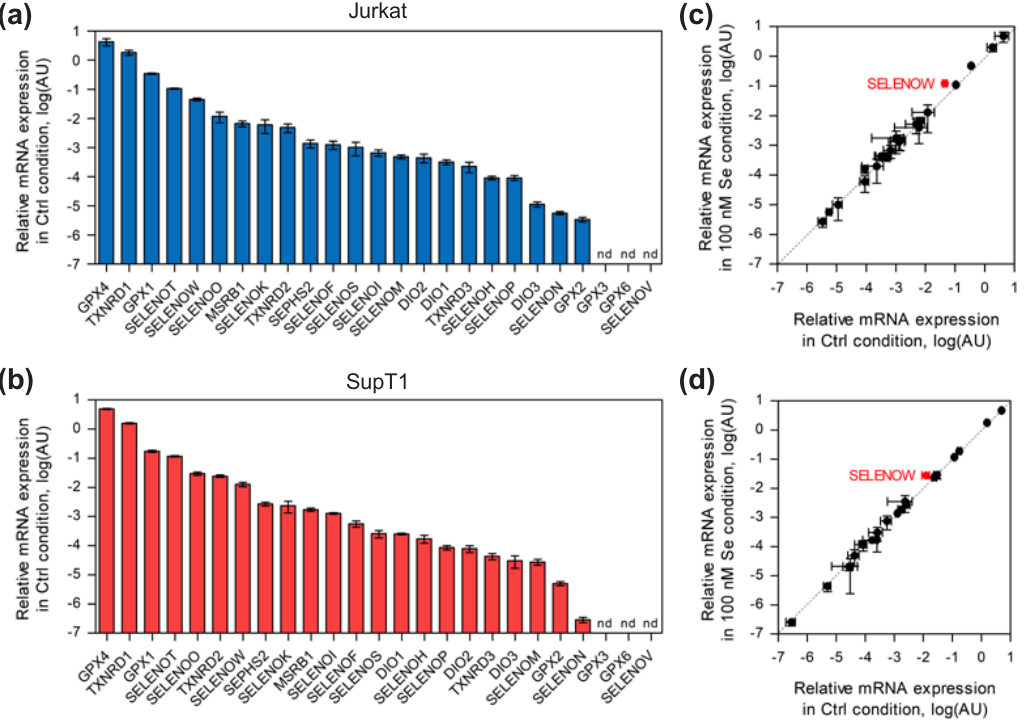
Figure 1. Analysis of selenoprotein mRNA levels in Jurkat and SupT1 in control conditions and in response to 100 nM selenium supplementation of culture media (three days). The geometrical mean of four housekeeping genes (HPCB, RPS13, HRPT, and GAPDH) was used to normalize mRNA abundance. In all panels, mRNA levels are represented in logarithmic scales. The values are given in Table S1. Selenoprotein mRNA levels in control medium (Ctrl) are represented for Jurkat ( a ) and SupT1 ( b ), from most to least abundant (from left to right). To evaluate the impact of selenium supplementation on steady state levels of selenoprotein mRNAs, the values obtained in selenium supplemented conditions (100 nM) were plotted as a function of values obtained with unsupplemented ones (Ctrl) for Jurkat ( c ) SupT1 ( d ) cells ( ± standard deviation). The experiments were done in biological triplicate and in technical triplicate. The selenoprotein genes with significant changes are labeled in red and the statistical analyses are given in Table